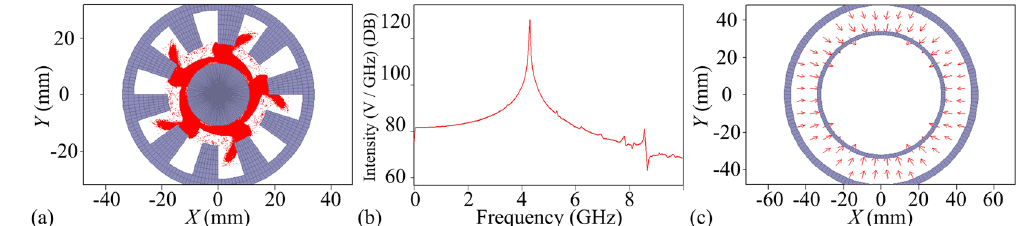
Figure 4. ( a ) Five electron spokes in the R θ plane of the ten-cavity RM. ( b ) Spectrums of electric fields in dB in the output port of the coaxial waveguide from 20 to 40 ns. ( c ) TEM mode in the output